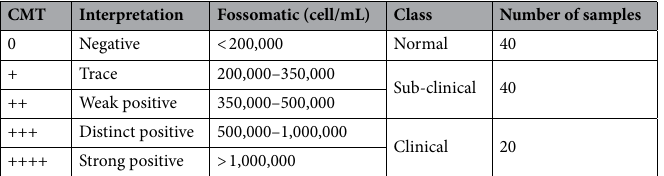
Table 1. Interpretation of results under CMT and Fossomatic machine, and classification of milk according to results.